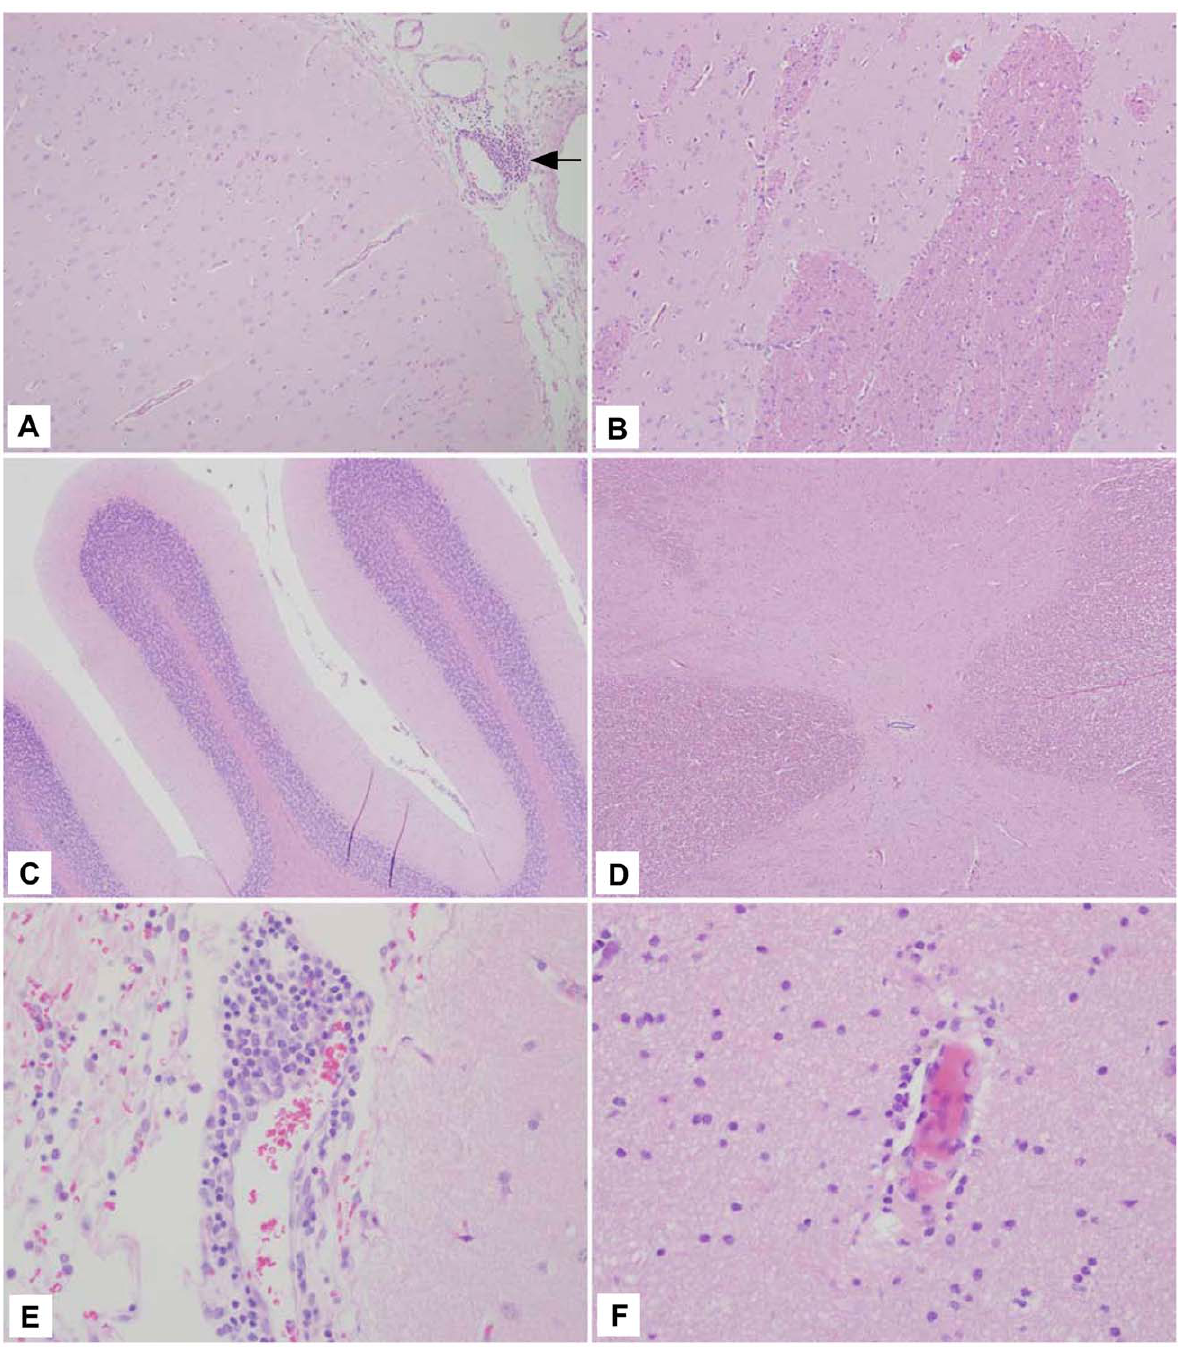
Figure 6. Representative rVSV-MARV-GP histology. (A) Frontal cortex (10 6 ) section from 59-09 that had a small perivascular cuff of lymphocytes. (B) Frontal cortex (10 6 ) section with no lesions. (C) Cerebellum (10 6 ) section with no lesions. (D) Spinal cord (10 6 ) section with no lesions. (E) Frontal cortex (40 6 ) section with a mild perivascular cuff of lymphocytes. (F) Frontal cortex (40 6 ) section with a scant perivascular cuff of